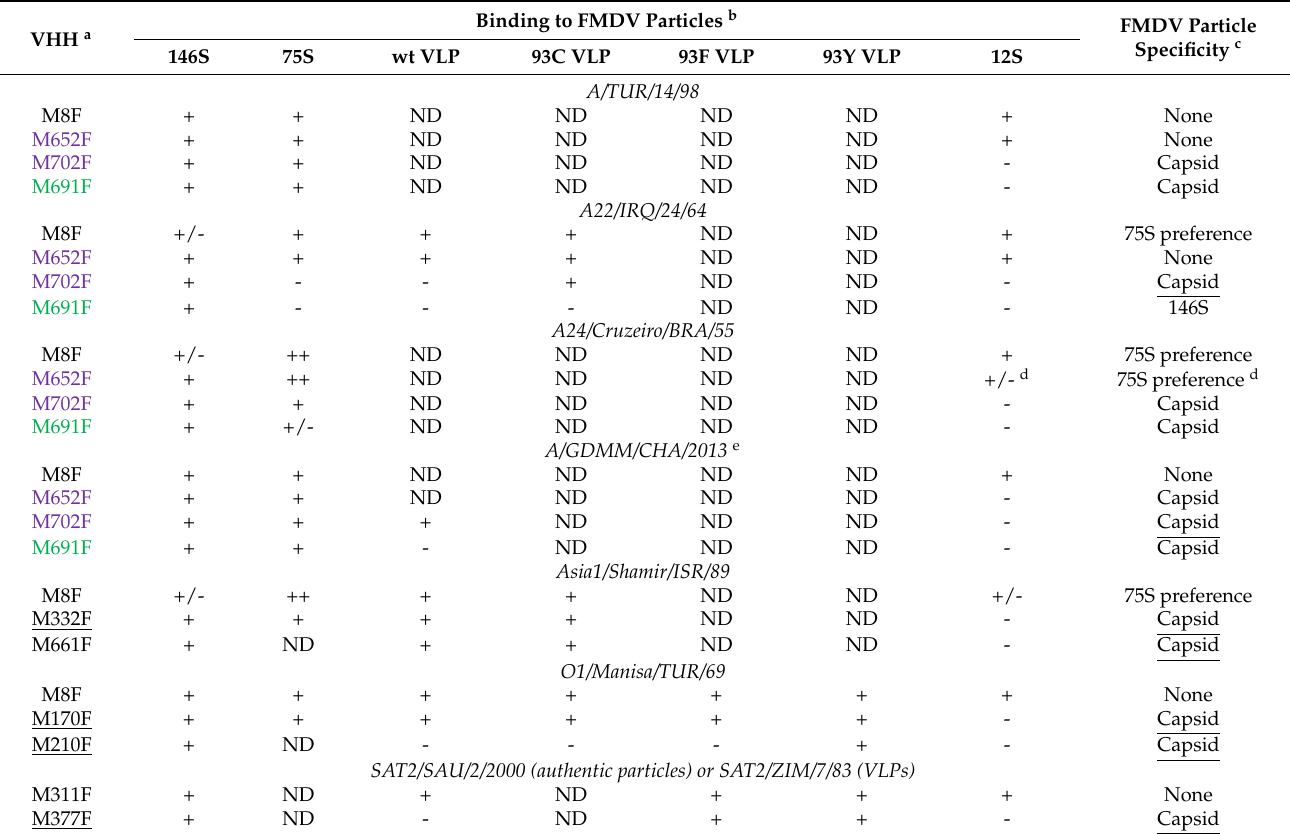
Table 4. Summary of VHH binding to different FMDV authentic particles and